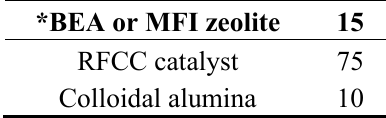
Table 1. Composition of the composite catalyst